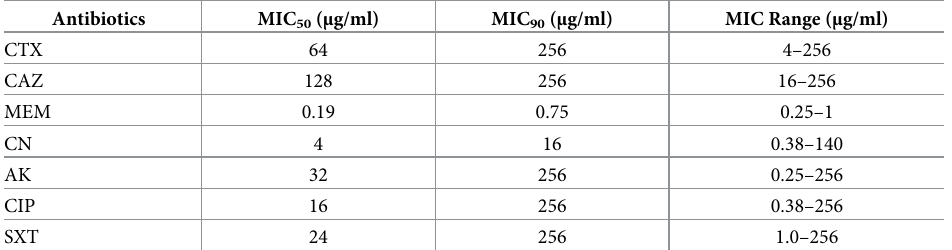
Table 5. Minimum Inhibitory Concentration of different antibiotics against ESBL producing E . coli